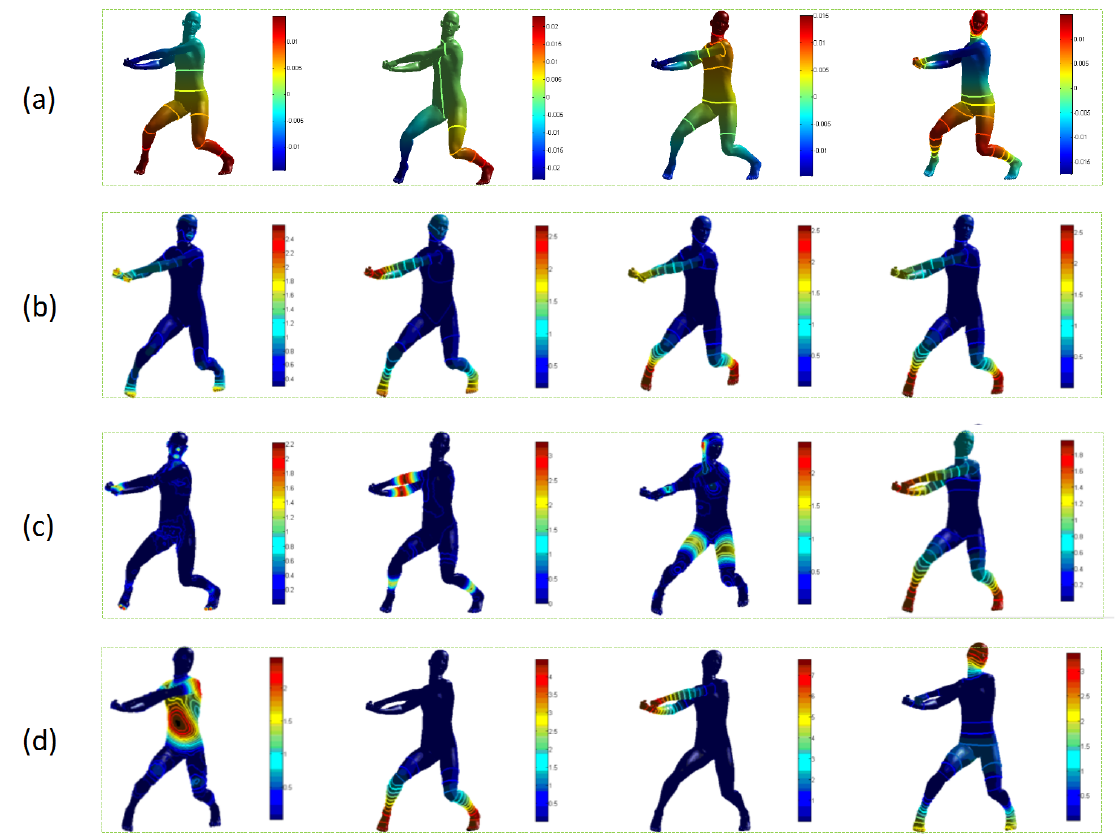
Figure 11. Comparisons of the levelsets of ( a ) Eigenvalue Decomposition (EVD), ( b ) HKSs, ( c ) global intrinsic symmetric invariant functions (GISIFs) , and ( d ) ours.